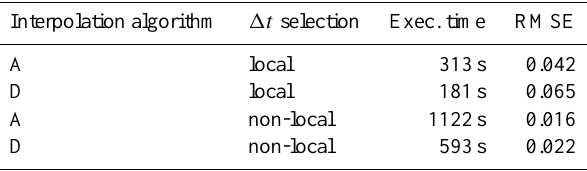
Table 3. Execution time and RMSE for experiments made with the ‘peaked’ diffusivity distribution, varying interpolation method and ∆ t selection algorithm.